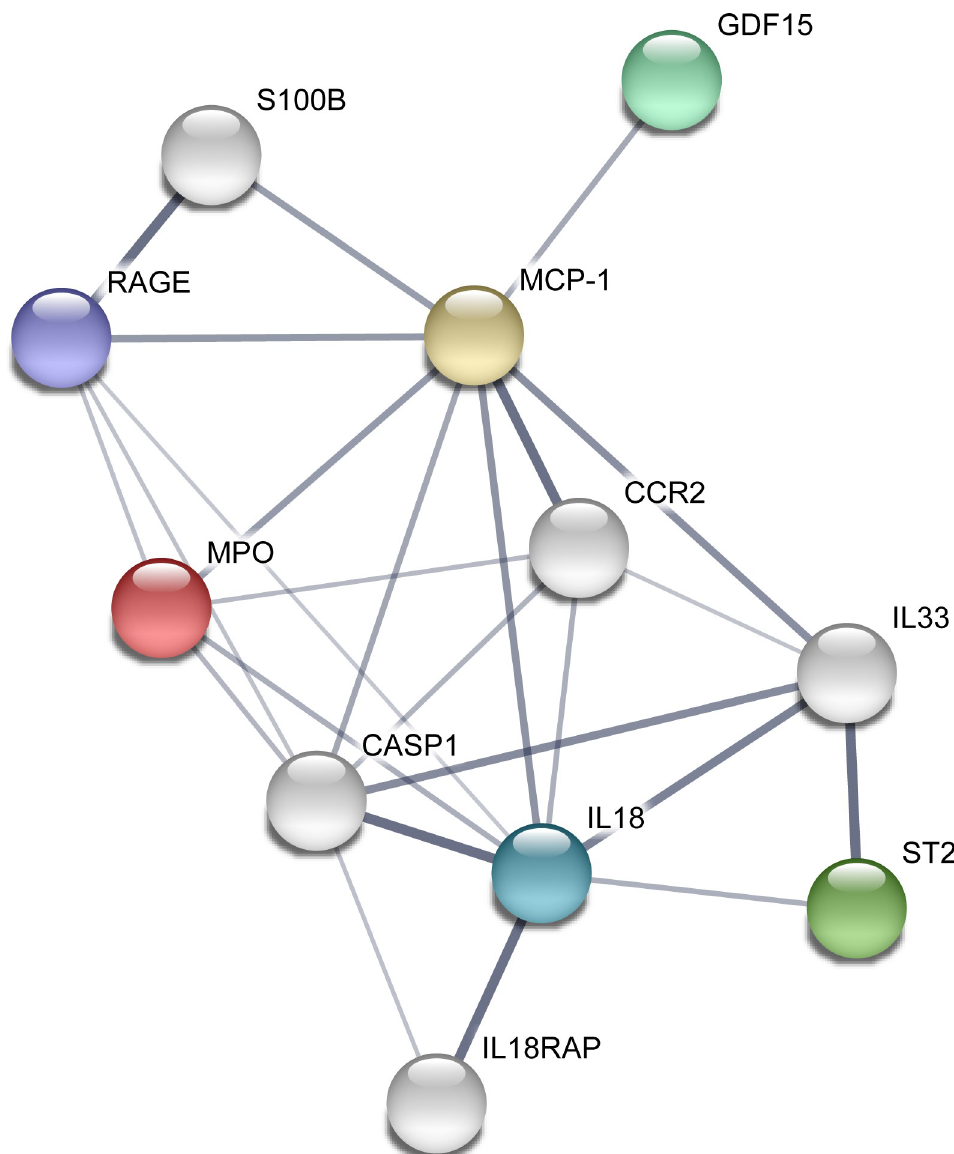
Fig 2. ICS components form an inflammatory network. STRING database query of the six ICS component analytes reveals a biologically interconnected network centered on IL-18 and highly related to inflammation ( p -value for protein interactions = 0.00022). ICS component analytes are shown as colored nodes (bold) while first level interacting proteins are shown as white nodes. Line width reflects the strength of data